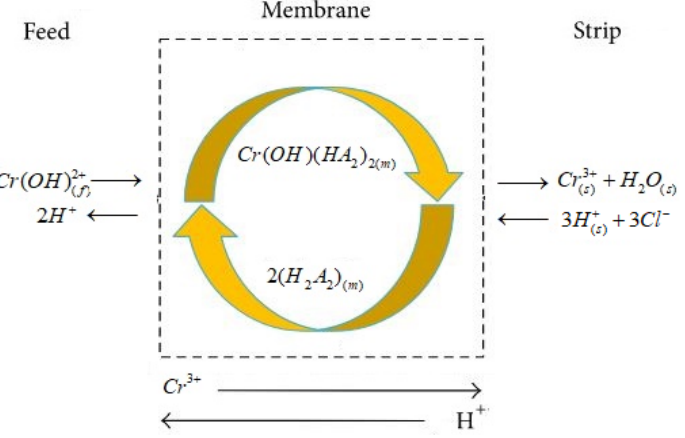
Figure 12. Transport mechanism in Cr (III) extraction.